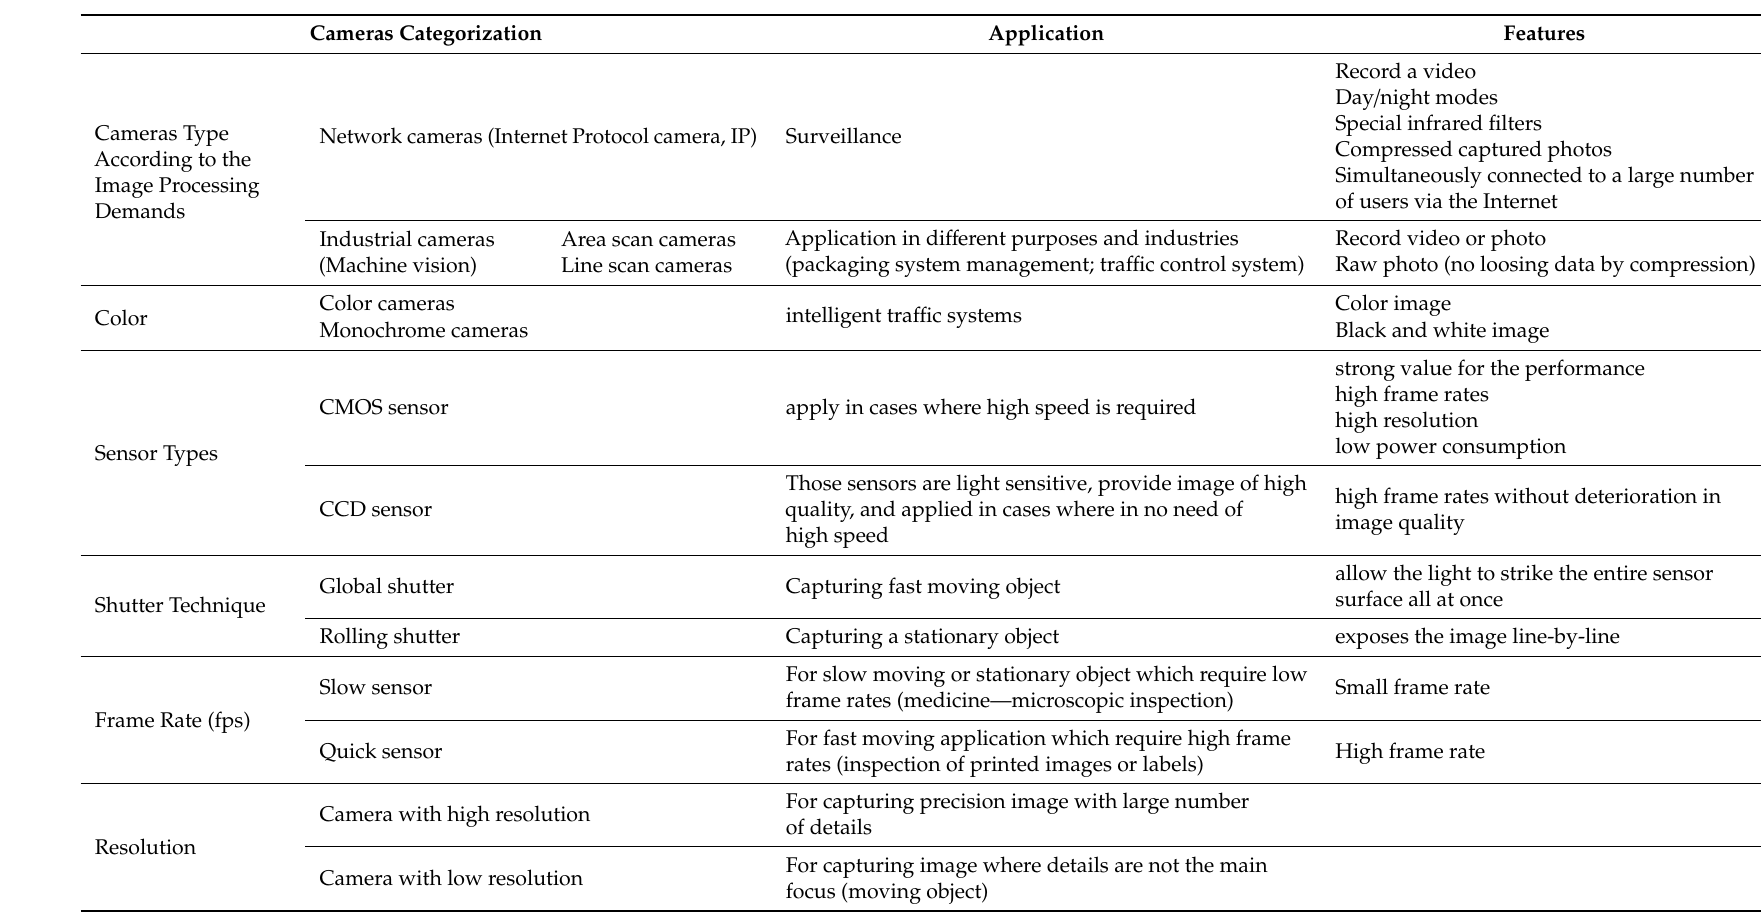
Table 1. Types of cameras in CVS